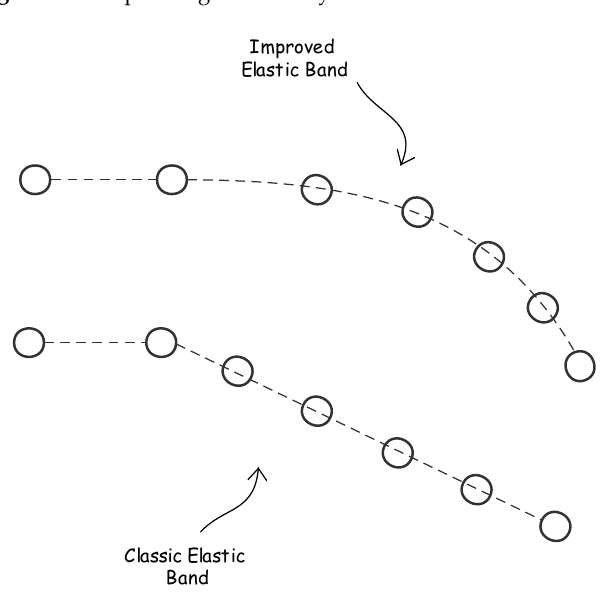
Figure 7. Abrupt change of velocity.